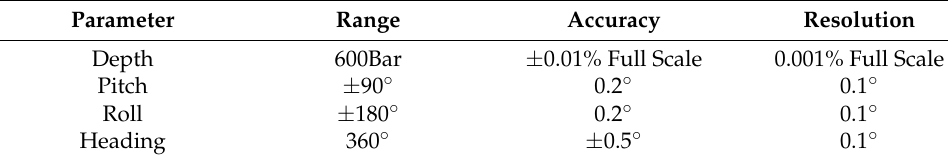
Table 6. Parameters of ISD4000.